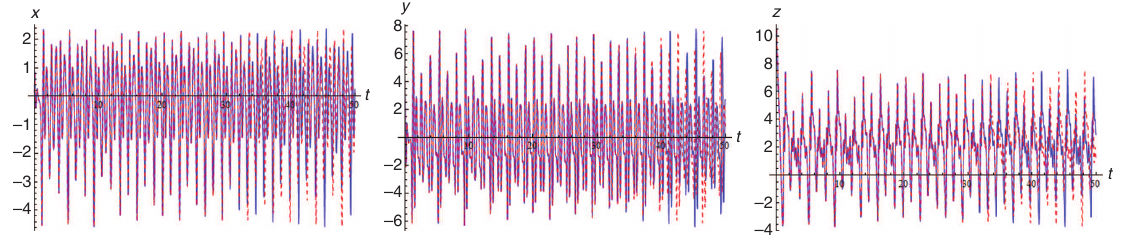
Figure 7: Sensitivity Tests of the Novel System ( x ( t ), y ( t ), z ( t )).